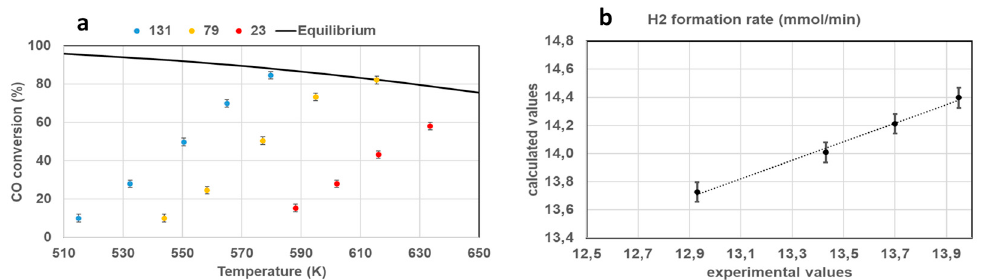
Figure 10. CO conversion as function of temperature ( a ) and comparison between hydrogen formation rate experimental vs. calculated values ( b ) for S1 catalyst with a H 2 O/CO = 24/7, at a τ = 23 ms.